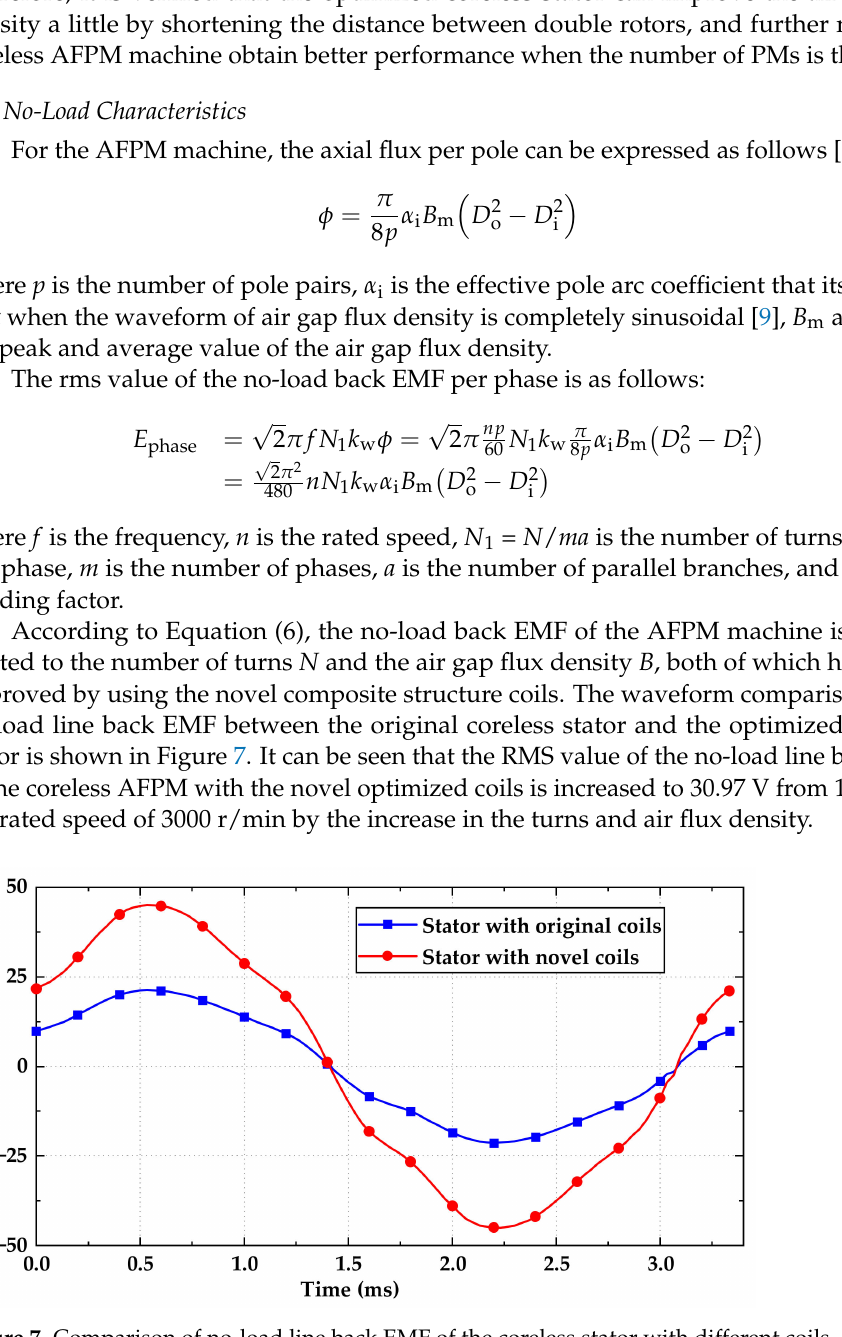
Figure 7. Comparison of no-load line back EMF of the coreless stator with different